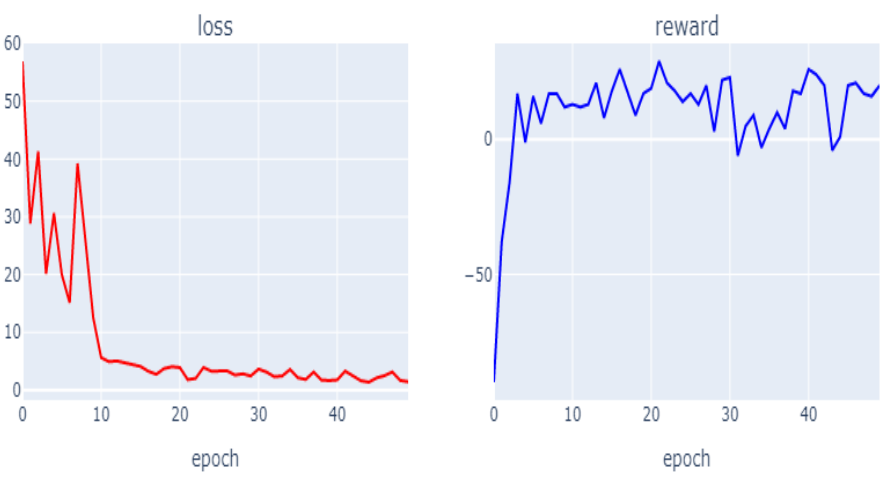
Figure 8. Learning results by substituting the Double Dueling DQN algorithm based on the proposed Total Resource on Google.